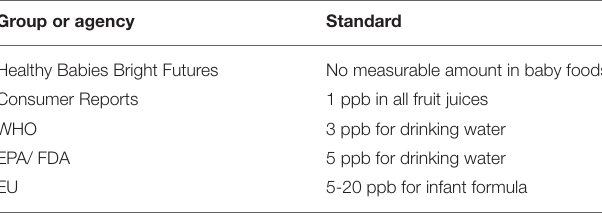
TABLE 4 | Proposed and existing cadmium standards.